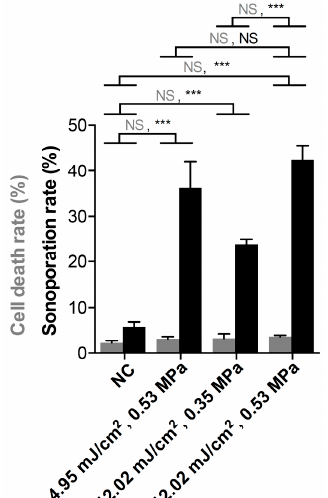
Figure 11. Comparison of sonoporation rate and cell death under di ff erent parameter sets. The laser PRF was fixed at 20 Hz in the experiments. Gray columns: cell death rate. Black columns: sonoporation rate. NC: negative control group. Student’s t -test was applied for determining the significant di ff erence between the two sets of data. ***, p < 0.001; NS: no significance. At least 350 cells were counted in each individual experiment. Each column indicates the mean and SD from three individual experiments.